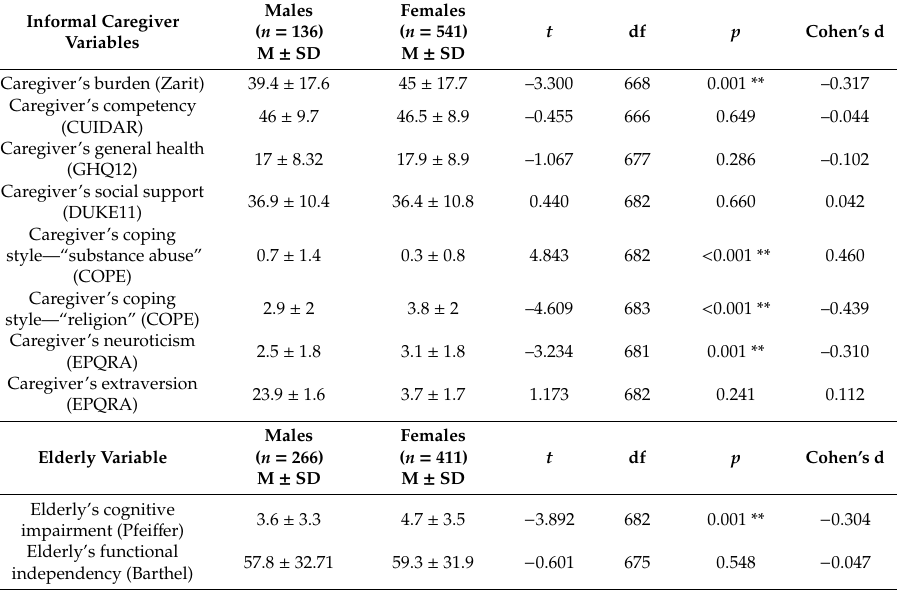
Table 2. Gender di ff erences in informal caregiver and elderly